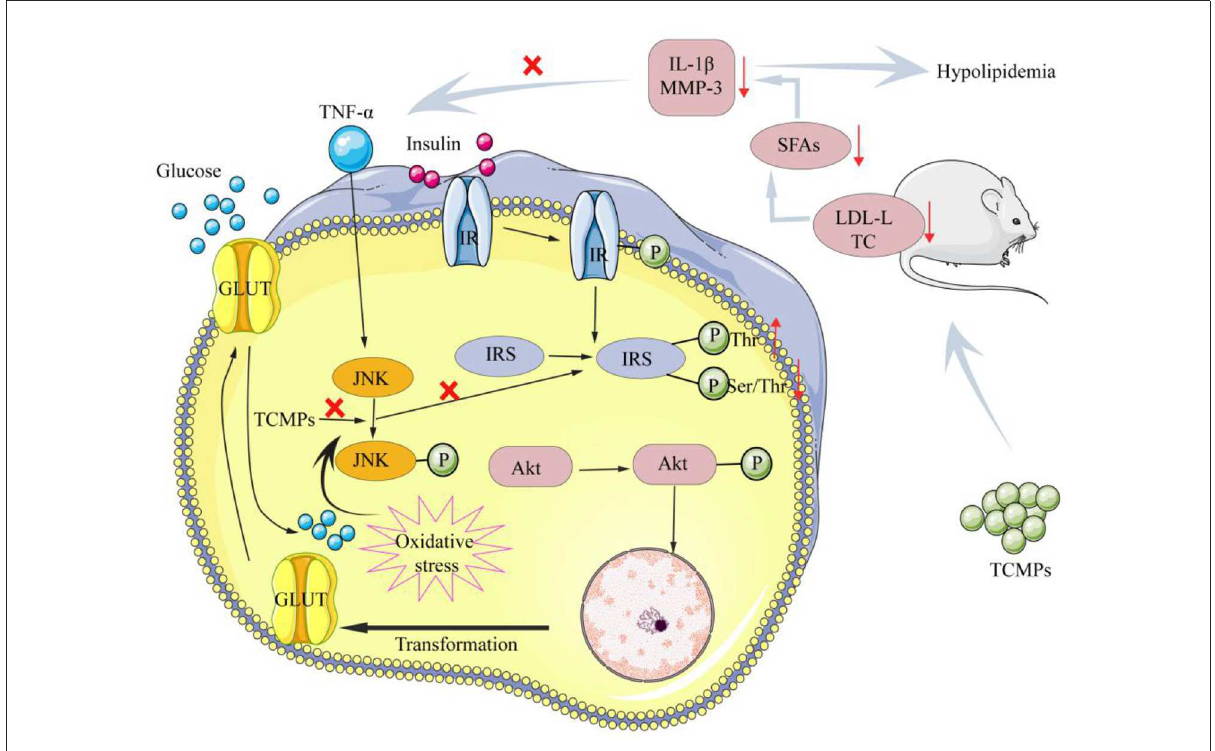
FIGURE5 The main hypoglycemic and hypolipidemic mechanisms of